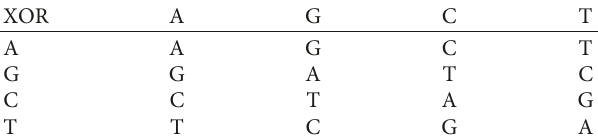
Table 2: DNA XOR